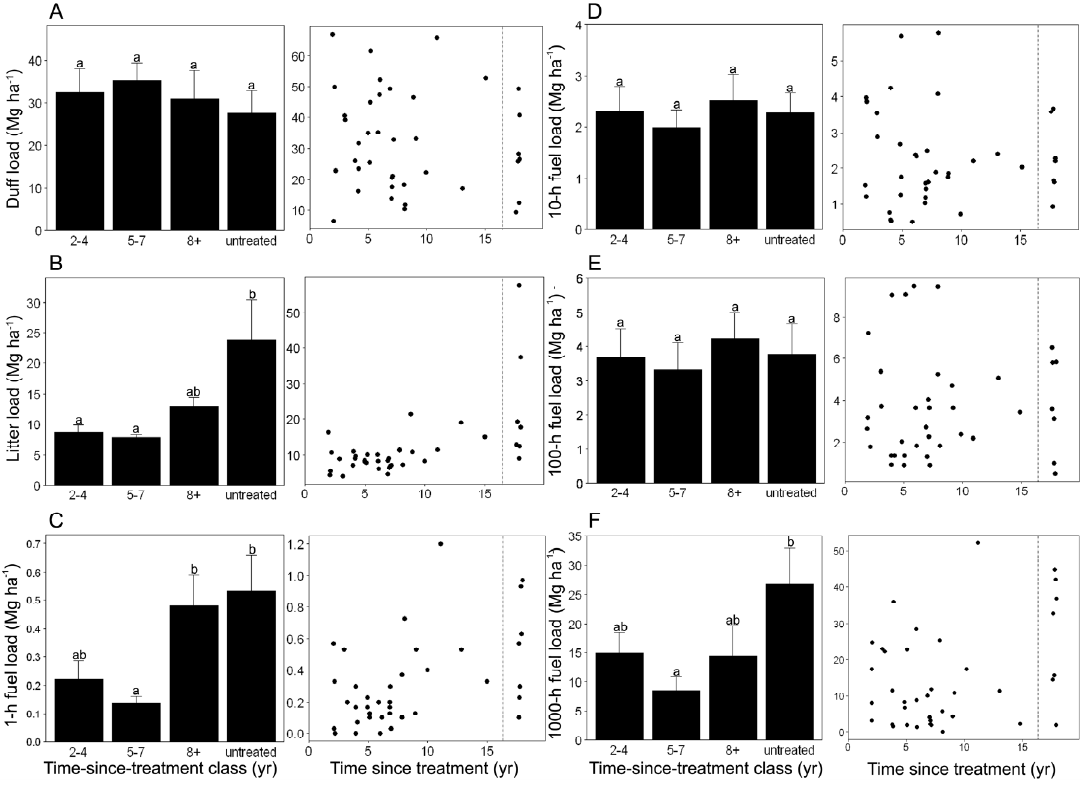
Figure 4. Dead surface fuel load by category in the eastside pine chronosequence ( n = 32) and control ( n = 7) sites. Fuel load in the ( A ) duff layer; ( B ) litter layer; and the ( C ) 1-h; ( D ) 10-h; ( E ) 100-h; and ( F ) 1000-h timelag categories. Left-hand panels show means ± SE for the three age class groups and the control group. Different letters above each bar indicate significant difference in means between groups (Tukey’s HSD multiple comparison test, p < 0.05). Right-hand panels show the relationship between time since treatment and each fuel category. Vertical dashed lines separate treated and untreated study